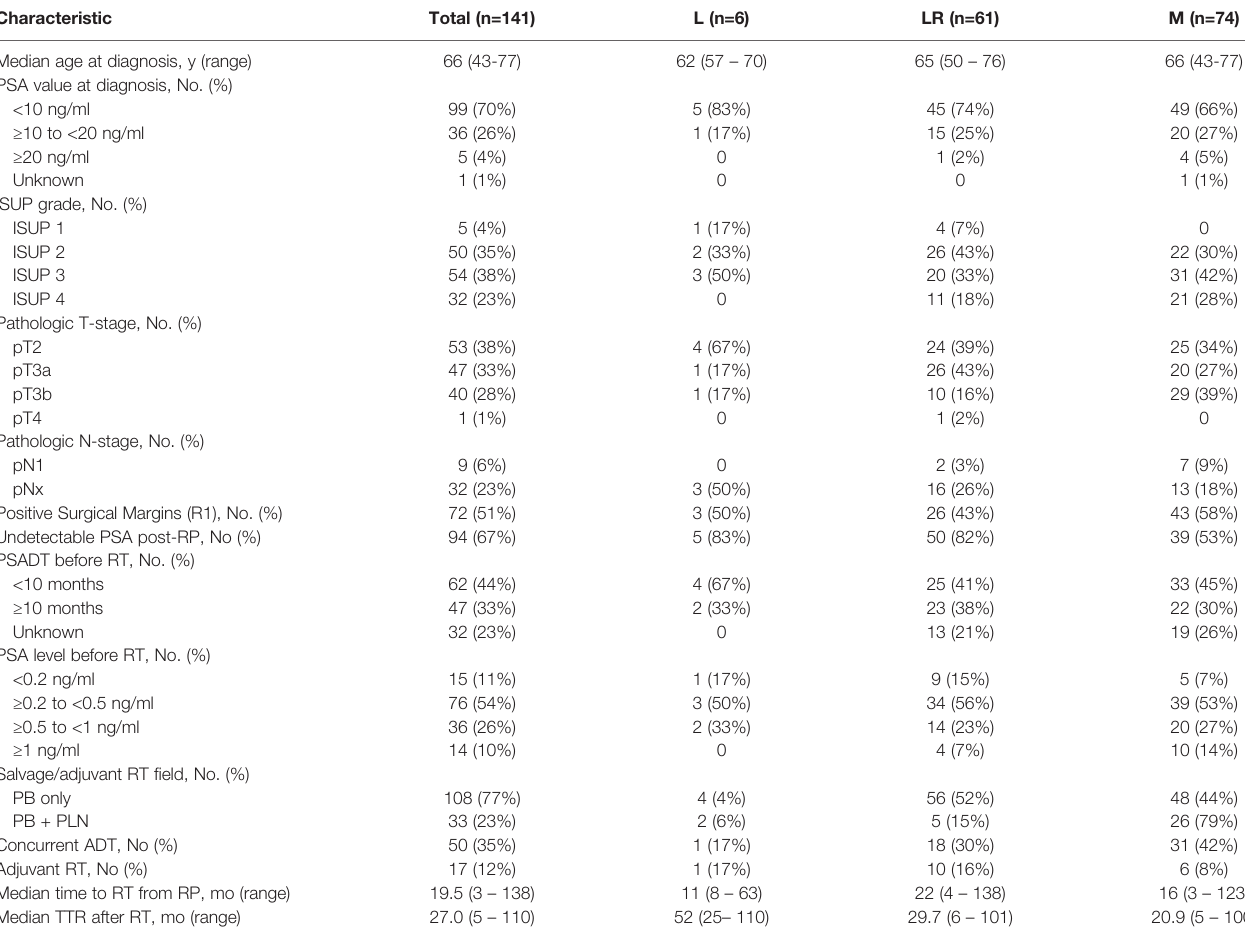
TABLE 1 | Baseline characteristics for all patients and subgroups of local-only (L), locoregional (LR) and metastatic (M) sites of recurrences.